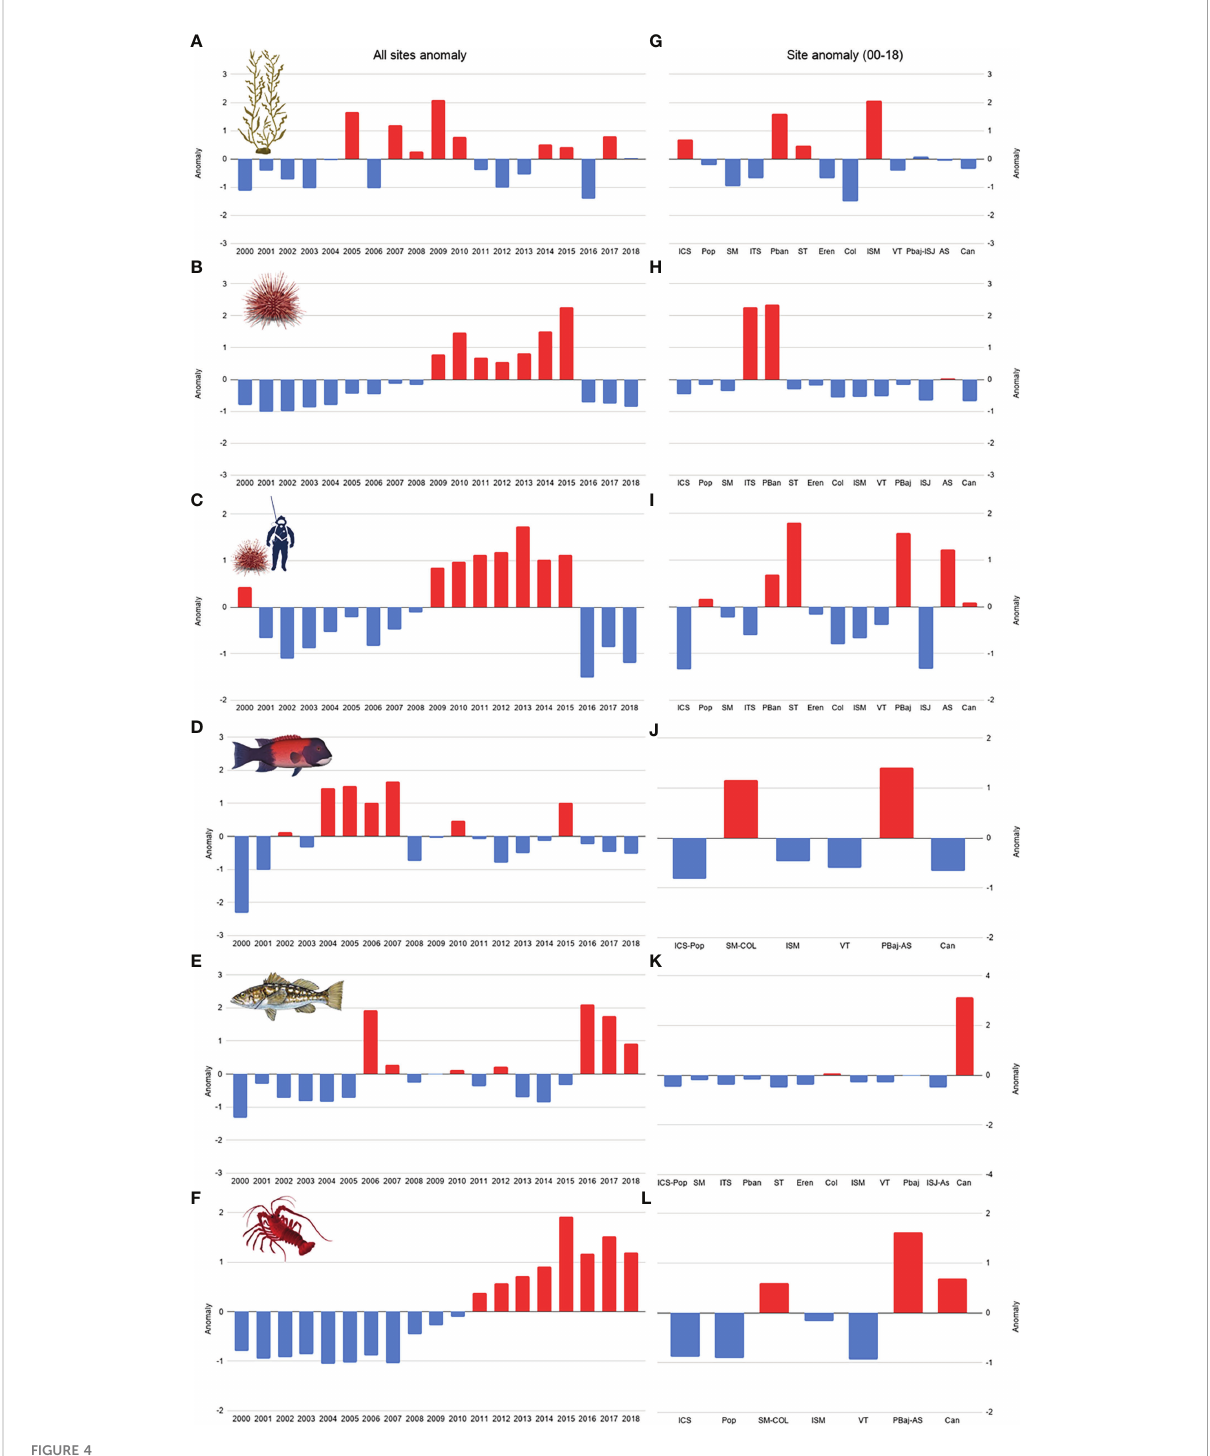
FIGURE 4 Kelp biomass (A) , red sea urchin population density (B) and catch (C) , California sheephead (D) , kelp bass (E) and spiny lobster catch (F) anomalies from 2000 to 2018- and 19-year site anomaly ( G-L ,